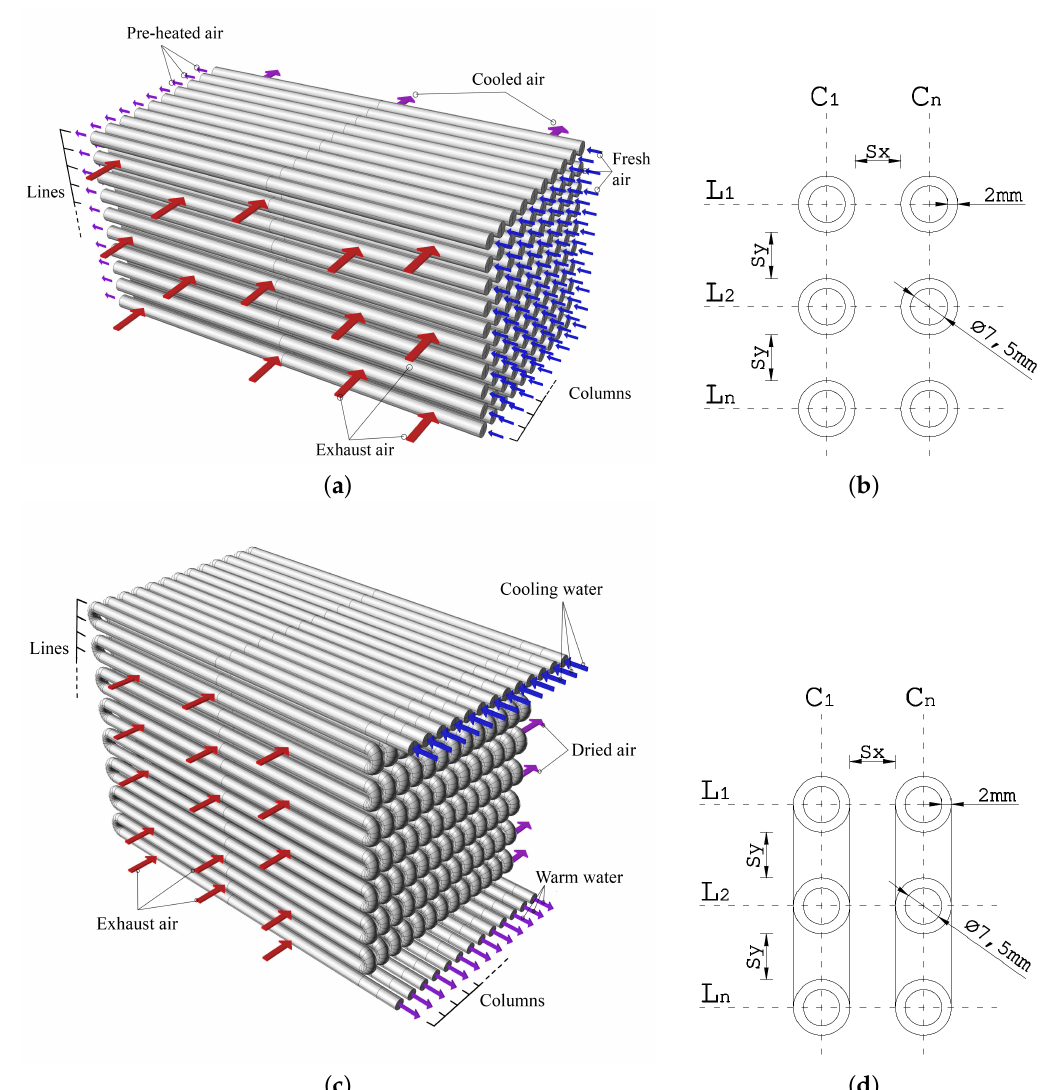
Figure 8. The spacing between the lines (L) and columns (C) of tube banks is equal in the horizontal and vertical direction s x , s y ; in air-to-air units ( a , b ) tubes are free and in air-to-water units ( c , d ) they are connected in a